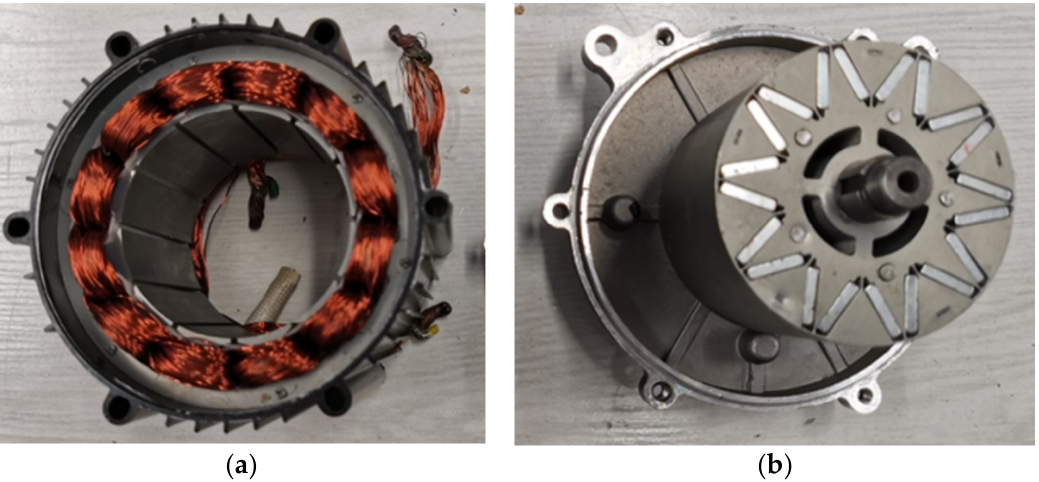
Figure 2. The schematic of the proposed IPMSM machine model.